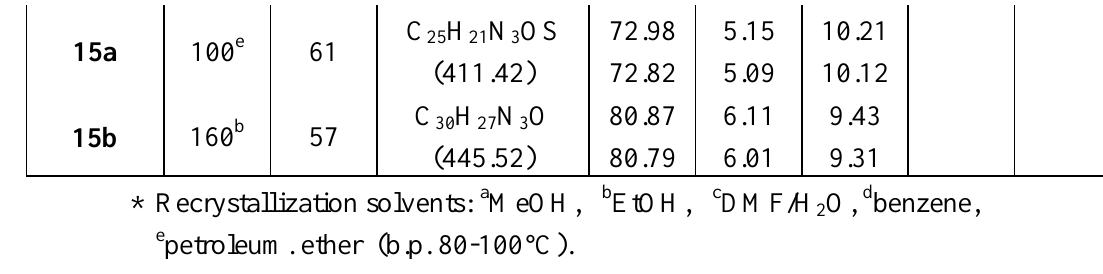
Table 2: IR spectral data for the synthesized compounds Compd. No.